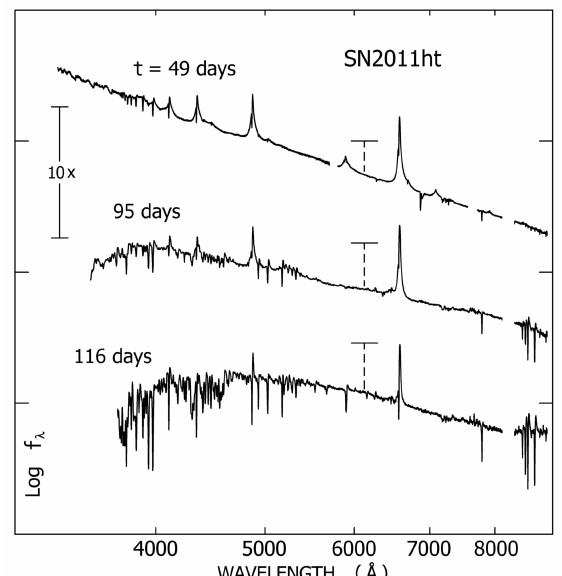
Figure 3. Spectrum of SN2011ht at three different times [42], cf. Figure 2. Both scales are logarithmic, the three tracings have differing vertical offsets, and the marks near 6100 Å indicate f λ = 10 − 14 erg cm − 2 s − 1 Å − 1 . Gaps at λ > 7000 Å are obscured by terrestrial atmospheric features. Concerning the line profiles, see Section 4.2 and Figure